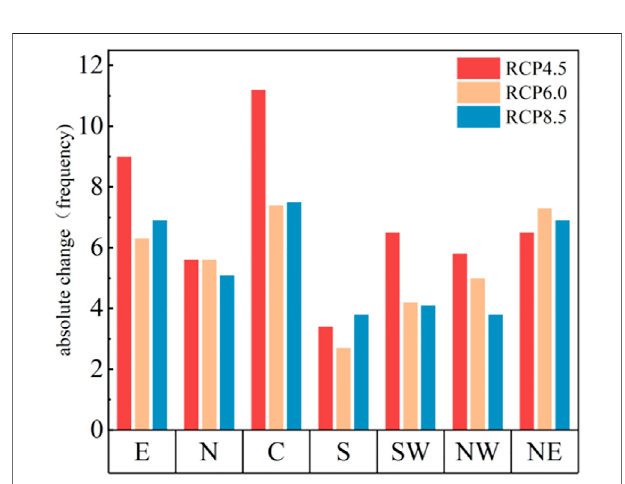
FIGURE8| TheprojectedchangesinASElastedformorethan5 daysin the different regions.